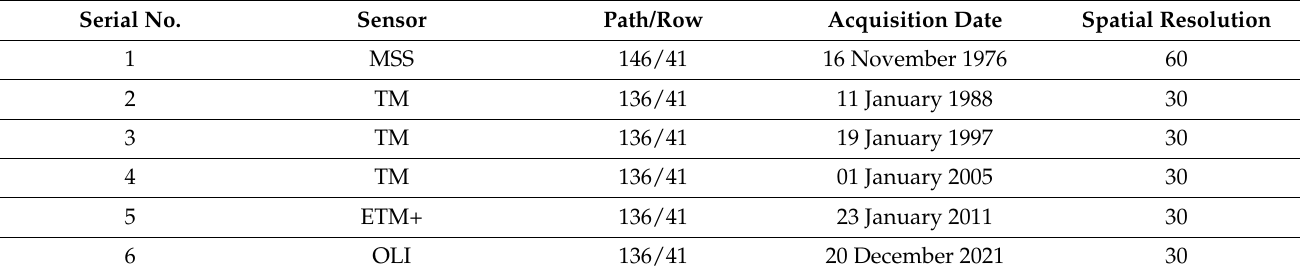
Table 1. Details about the data sources used in the